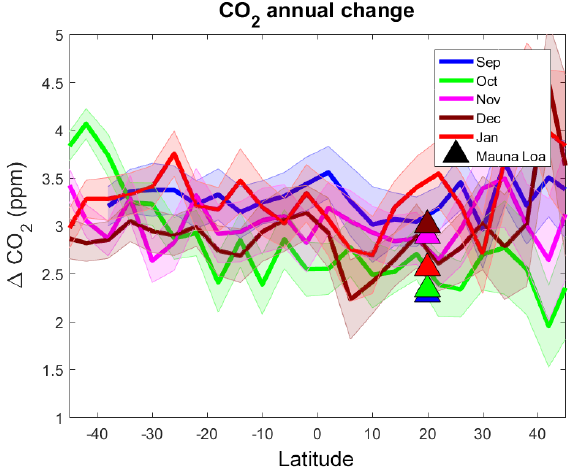
Figure 12. Annual change of X CO zonal means from OCO- 2 2 observations (lines) and from in situ measurements at Mauna Loa, Hawaii (triangles), plotted in different colors for the differ- Figure 13. Time series of weekly average OCO-2 X CO ent months of measurements. Differences are between 2015 and ments near Hawaii. Glint water measurements selected with the data 2014, except for January, which is January 2016–January 2015. The quality flag from the Lite shaded areas represent the standard deviations.